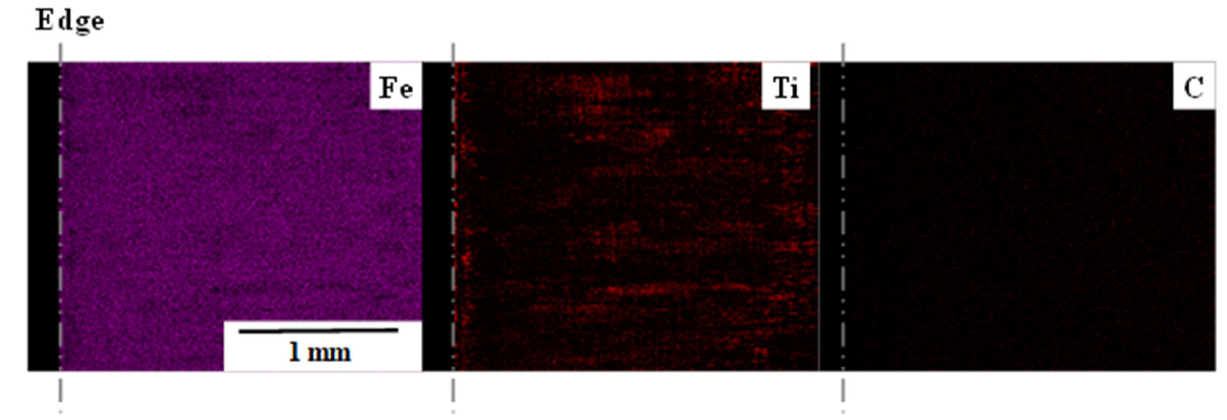
Figure 8. Element mapping of the punch side surface around the punch edge.